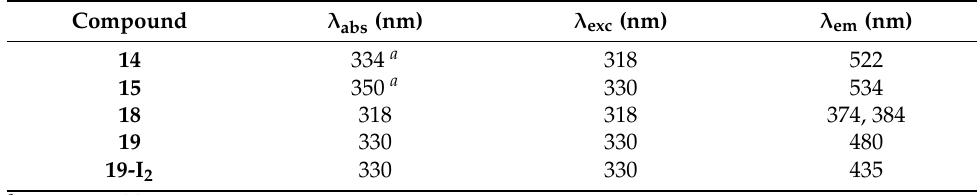
Table 2. Peak maxima of compounds in H 2 O containing 0.1% DMSO. Compound λ abs